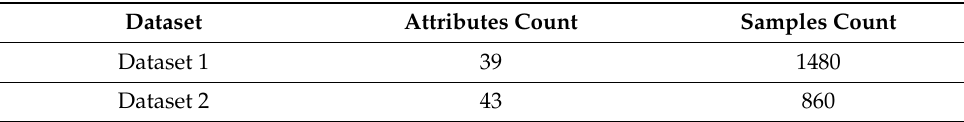
Table 2. Details of datasets used in the